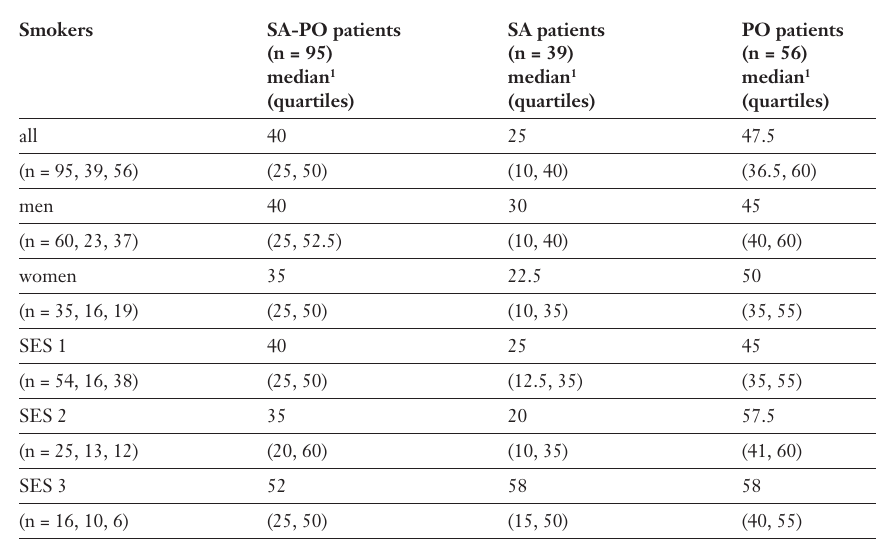
Smoking history (pack-years), gender and socioeconomic